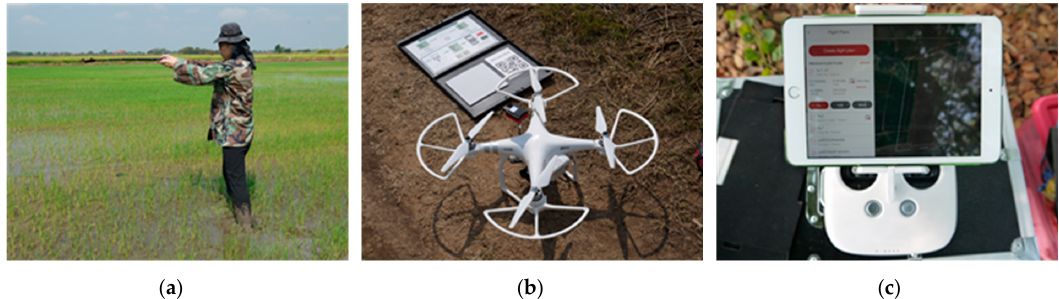
Figure 3. ( a ) Leaf area index––LAI measurement with a LAI–2200 Plant Canopy Analyzer. ( b ) and ( c ) Data collection by a DJI Phantom 3 with a multispectral camera at the test site.